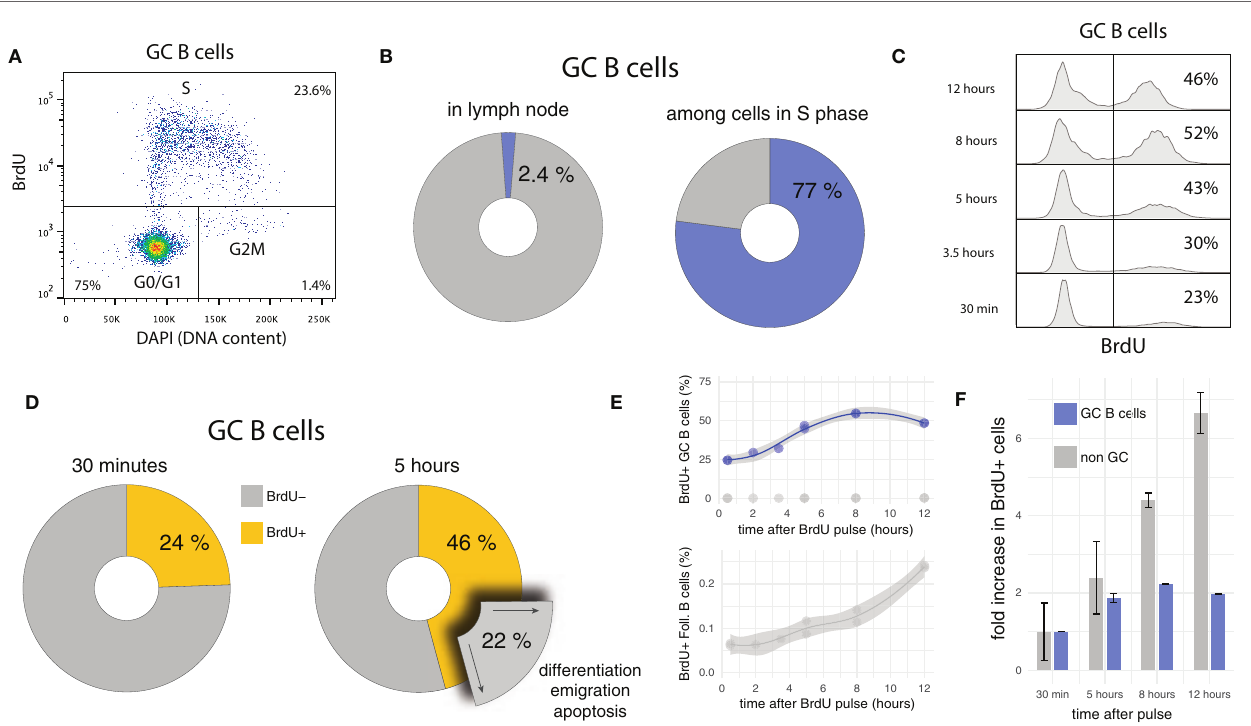
FiGUre 1 | BrdU pulse chasing of GC B cells. (a) Bi-variate scatter plot of DAPI (DNA content) versus BrdU 30 min after the pulse identifies cells in G0/G1 phase, in S phase, and in G2M phase. (B) Only a small fraction of cells (2.4 ± 1%) in draining lymph nodes are GC B cells, but due to their fast cycling, they dominate the population of cells in S phase (77 ± 0.01%). (C) Representative BrdU pulse-chase data, in which GC B cells are harvested at different times (from 30 min up to 12 h) after the BrdU pulse. (d) Between 30 min and 5 h after the BrdU pulse, the proportion of BrdU + among GC B cells increases in average by 22%. Assuming quasi-steady state (during 4.5 h), an equivalent proportion of GC B cells must egress from the GC through differentiation or apoptosis during the same period of time. (e,F) Proportions of BrdU + GC B cells approximately double within 5–6 h, and then stabilize at approximately 50%, twofold of the initial value. By contrast, cells that do not express the GC B cell marker (e.g., follicular B cells) initially contain few BrdU + cells, but continuously increase this proportion over